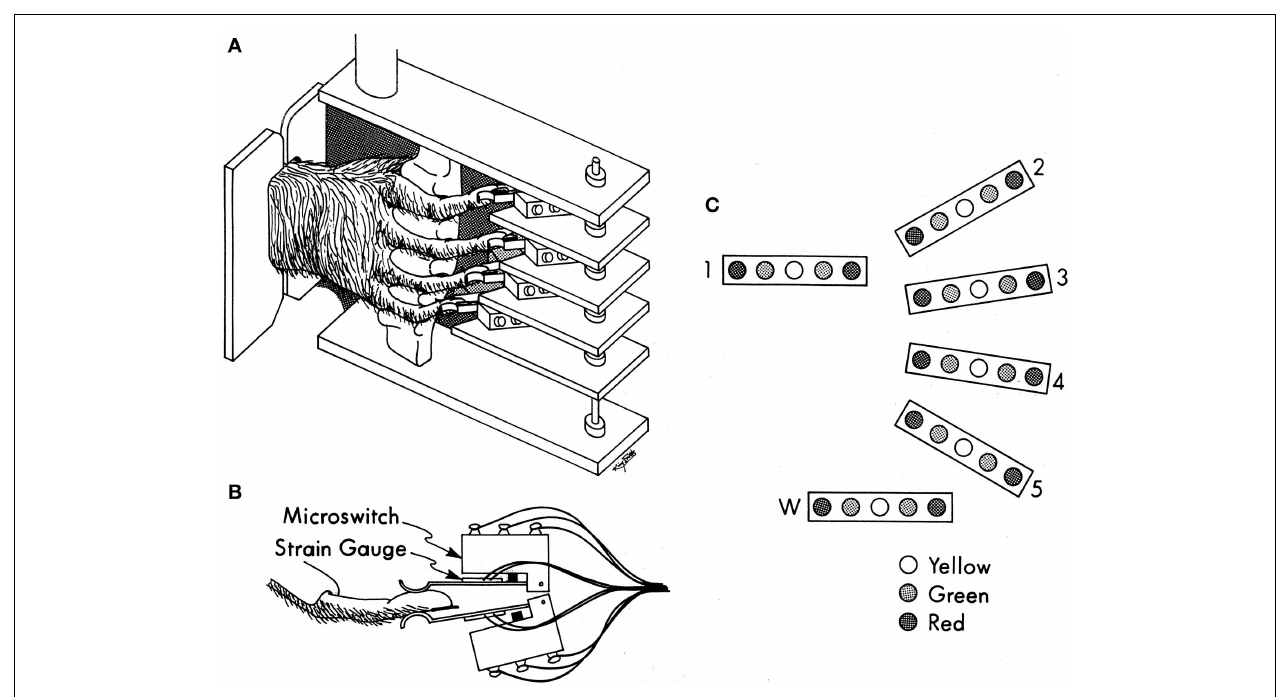
microswitch. (C) Display of LEDs used to instruct movements (red) and to inform the monkey for which fingers both switches were open (yellow), or if not, then which one was closed (green). Reproduced with permission from Ref.